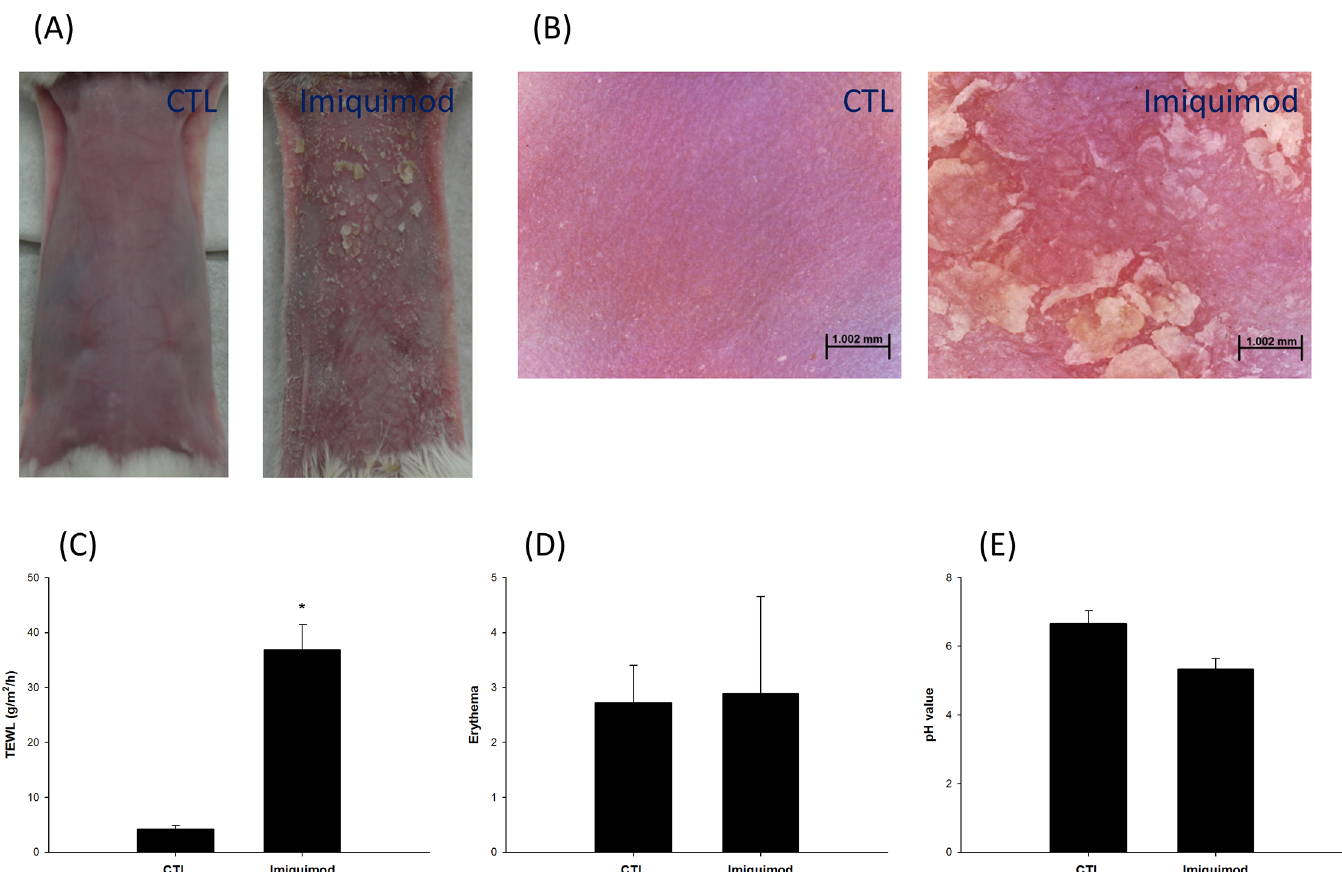
Fig 1. Gross observation and physiological parameters of mouse skin treated with and without imiquimod cream: (A) the gross imaging by digital camera; (B) the gross imaging by handheld digital microscope; (C) transepidermal water loss (TEWL); (D) erythema; and (E) skin surface pH value. The control group corresponds to the mice treated with the vehicle. The data of physiological assessment are presented as the mean of six experiments ± S.D. * , p < 0.05 between control and imiquimod groups.